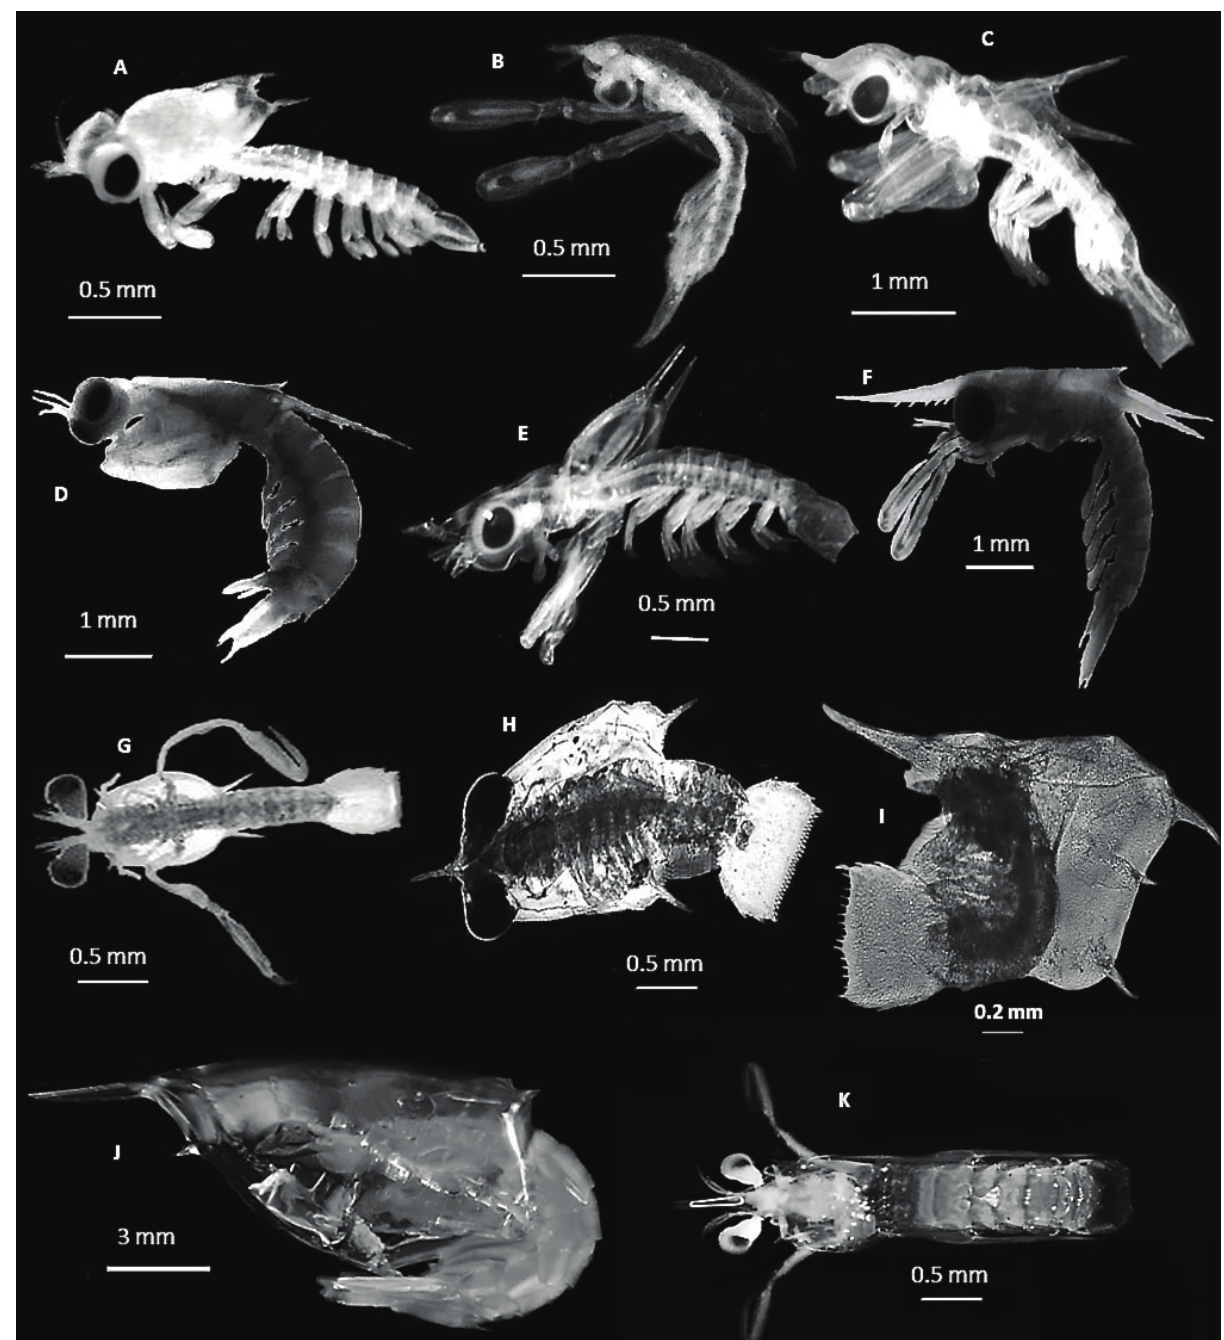
Figure 3. Stomatopod larvae collected at the national parks Sistema Arrecifal Veracruzano (SAVNP) and Arrecife Puerto Morelos (APMNP). A, Neogonodactylus oerstedii (Hansen, 1895), stage II pseudozoea; B, N. oerstedii , stage III erichthus; C, N. oerstedii , stage IV erichthus; D, N. oerstedii , stage VI erichthus; E, Neogonodactylus wennerae Manning and Heard, 1997, stage IV erichthus; F, N. wennerae , stage VIII erichthus; G, Pseudosquillidae genus and species indeterminate, stage VI erichthus; H, Lysiosquilloidea genus and species indeterminate, antizoea; I, Lysiosquilla sp., antizoea; J, Lysiosquilla scabricauda (Lamarck, 1818), erichthus; K, Nannosquilla adkisoni Camp and Manning, 1982,